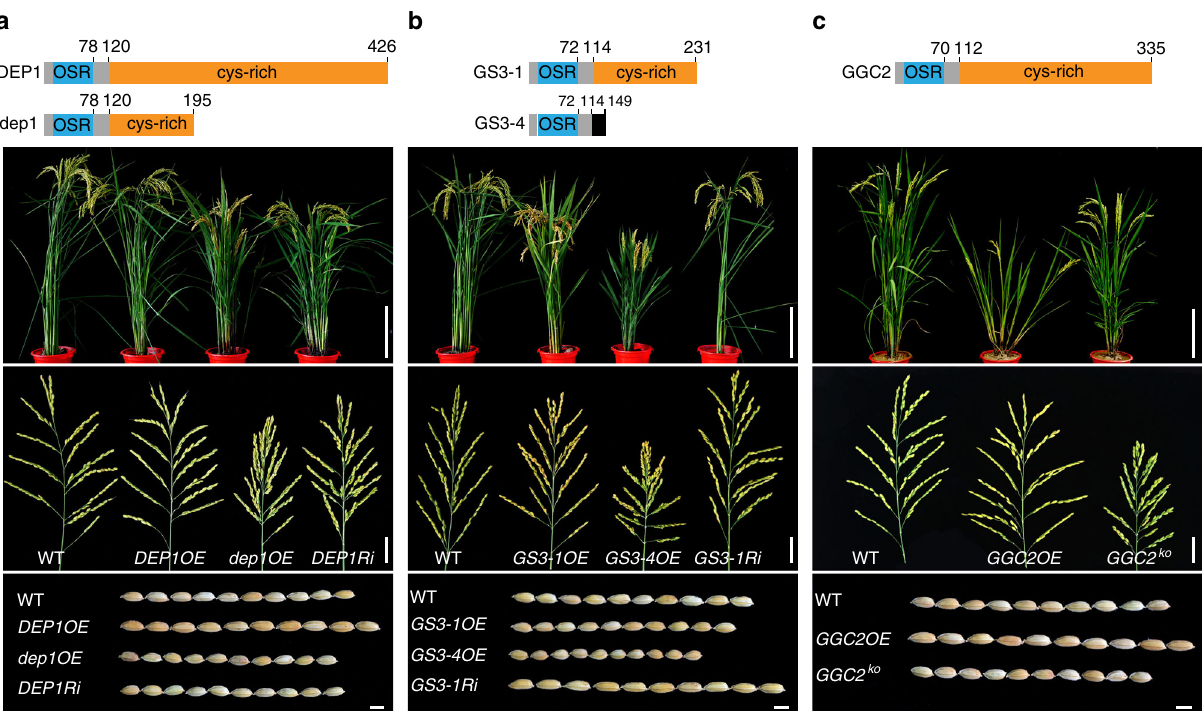
Fig. 1 Genetic effects of three G γ proteins on grain size and plant morphology. The structures of the proteins are shown on top of each panel, with the numbers of residues of each protein indicated. Plant, bar = 20 cm; Panicle, bar = 5 cm; grains, bar = 5 mm. a Top: the protein structures of DEP1 and dep1. Bottom: whole plants, panicles, and grains of WT (wild type ZH11), DEP1OE , dep1OE , and DEP1Ri plants. b Top: the protein structures of GS3-1 and GS3-4. Bottom: whole plants, panicles, and grains of WT, GS3-1OE , GS3-4OE , and GS3-1Ri plants. c Top: the protein structure of GGC2. Bottom: whole plants, panicles, and grains of WT, GGC2OE , and GGC2 ko